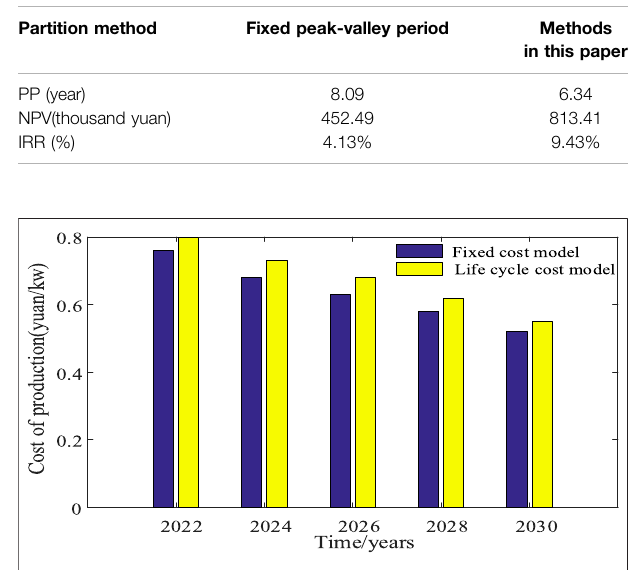
Table 4 . The curve of “ peak cutting and valley fi lling ” is shown in Figure 6 .